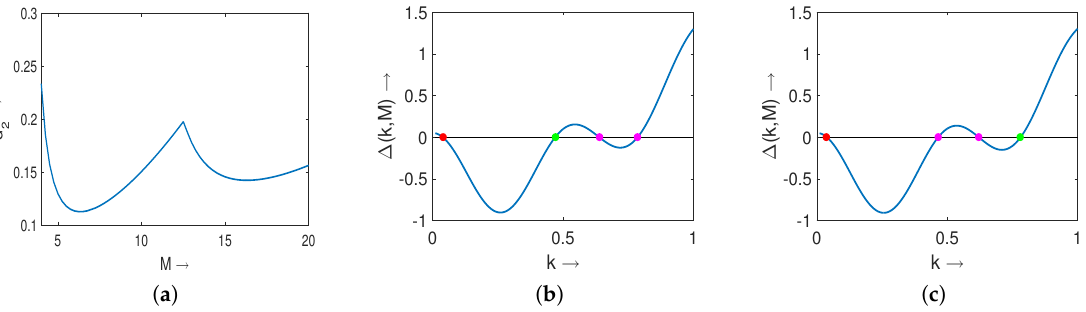
Figure 2. Turing bifurcation curve on the ( M , d 2 )-parameter plane ( a ). Stationary Turing patterns exist above the bifurcation curve. The functions ∆ ( k , 12.5) ( b ) and ∆ ( k , 12.7) ( c ).The root corresponding to the Turing instability is shown in